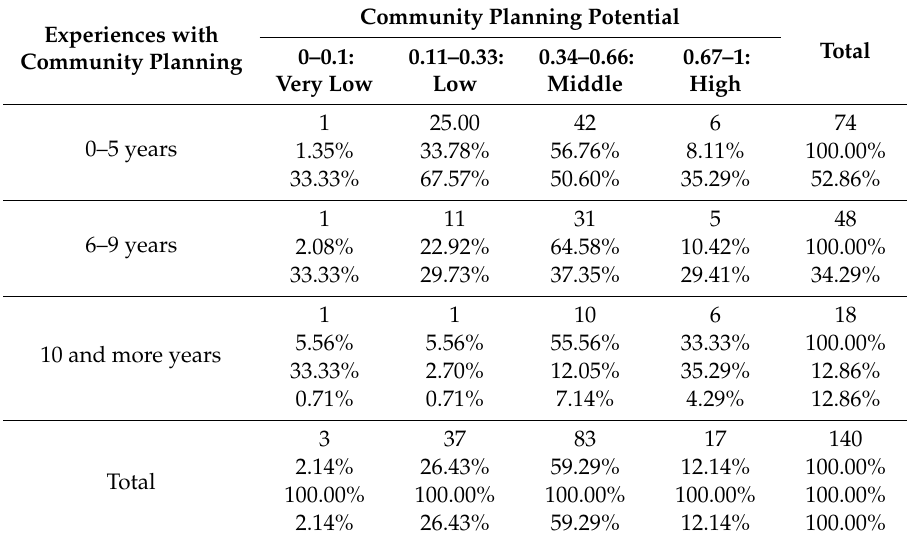
Table 7. Experiences with Community planning × Community Planning Potential (count, row %,column %, total %).